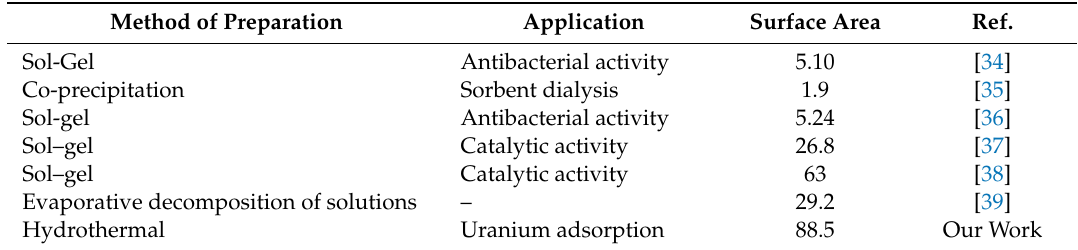
Table 1. Comparison of the surface area the fabricated adsorbent mesoporous zirconium phosphate ion-exchanger (NaZrP-CEX) with the previously reported NaZrP